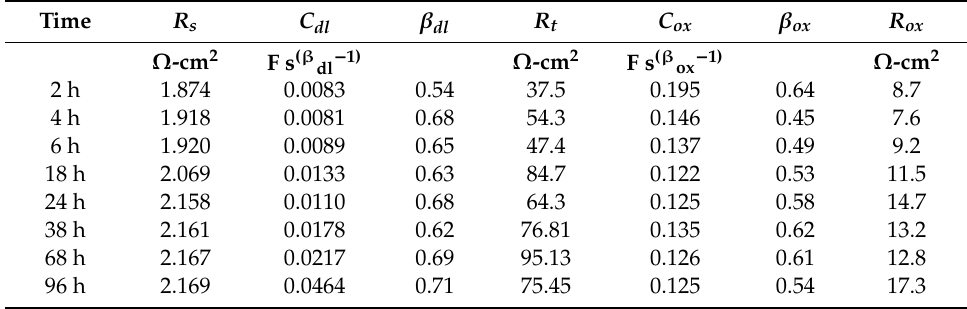
Figure 14. Nysquist diagram of VM12 layer in (LiNaK)NO 3 (ternary salt with lithium content) of 100 h at 2 h, 4 h, 6 h, 18 h, 24 h, 38 h, 68 h, and 96 h at 550 ◦ C. Table 9. Fitting results of the impedance spectra of VM12 during corrosion in the presence of (LiNaK)NO 3 (ternary salt with lithium content) at 550 °C.